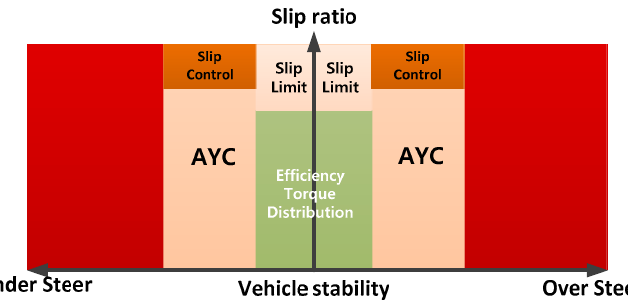
Figure 8. Operating region of integrated driving torque distribution strategy.